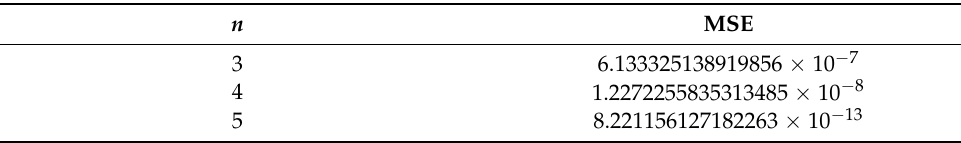
Table 1. The MSE under different parameter